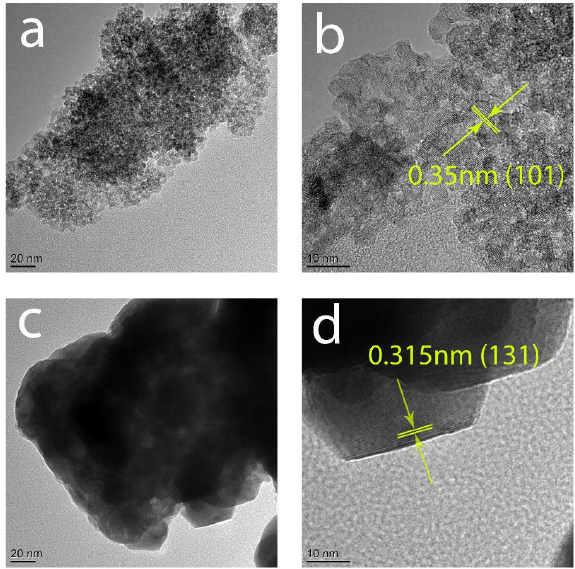
Figure 5. ( a ) TEM images of PC500 titania; ( b ) high resolution TEM image of PC500 titania; ( c ) TEM image of sample BWO2; ( d ) high resolution TEM image of sample